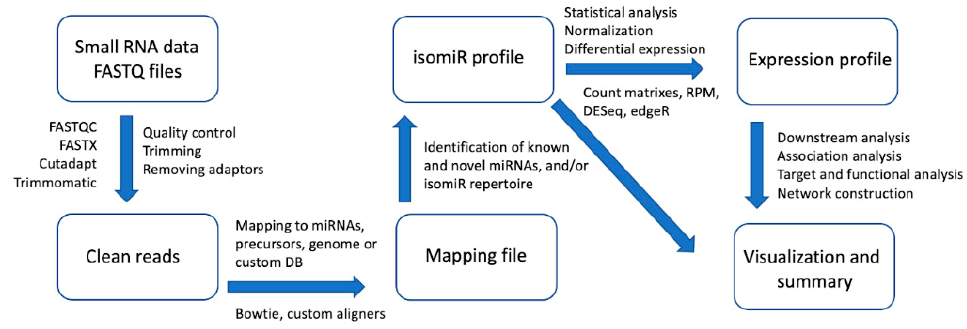
Figure 2. General summary of the workflow used in miRNA and isomiR analysis tools.